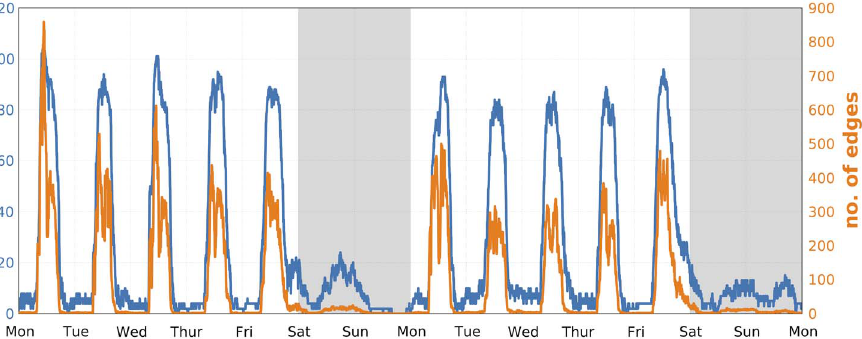
Figure 5. Weekly temporal dynamics of interactions. Face-to-face interaction patterns of participants in 5-minute time-bins over two weeks. Only active participants are included, i.e. those that have either observed another person or themselves been observed in a given time-bin. On average we observed 29 edges and 12 nodes in 5-minute time-bins and registered 10 634 unique links between participants.